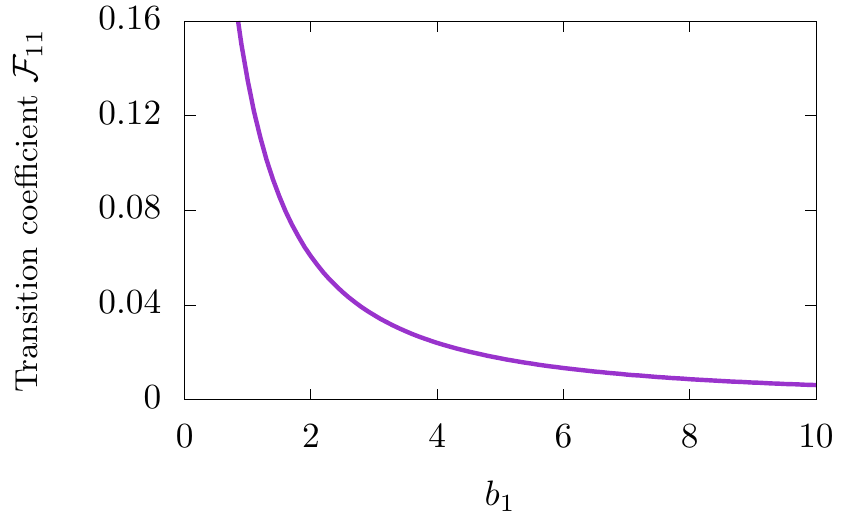
Figure 12 . The transition coefficient F 11 (∆ E ) , plotted with respect to varying b 1 for accelerated atoms in thermal background considering Minkowski modes and (1 + 3) dimensions.